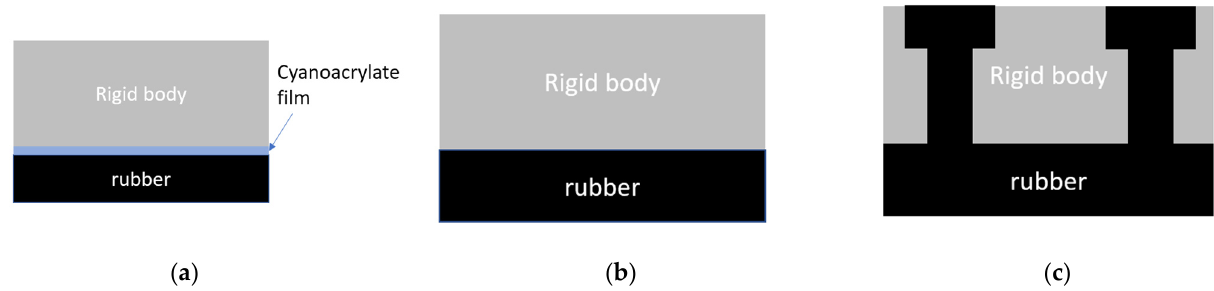
Figure 12. Different ways of bonding rubber to a “rigid” body like metal or plastic: ( a ) cyanoacrylate as film; ( b ) vulcanizing makes a tight connection; ( c ) form closure and vulcanizing is the best way to connect rubber with rigid structures (including special surface treatments).